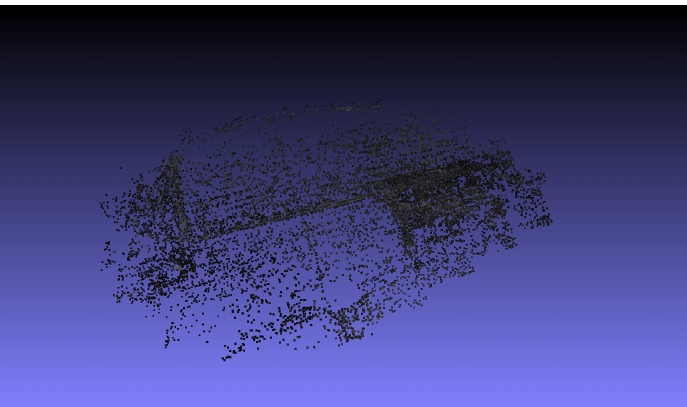
Figure 10. Sparse point cloud representation of the surveyed